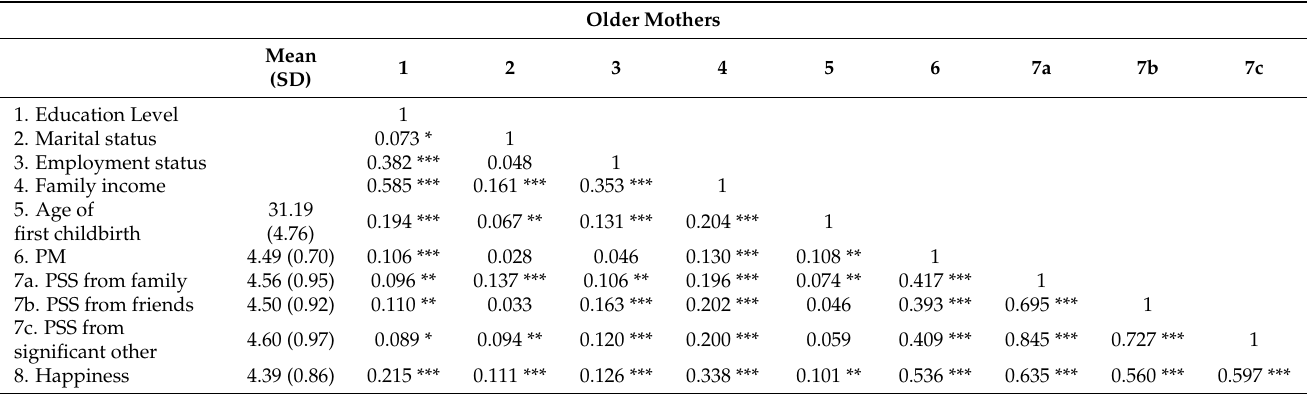
Table 3. Summary of means, standard deviations, and zero-order correlations among the demo- graphic control variables, presence of meaning in motherhood, perceived social support (PSS), and happiness among older mothers ( n = 931).